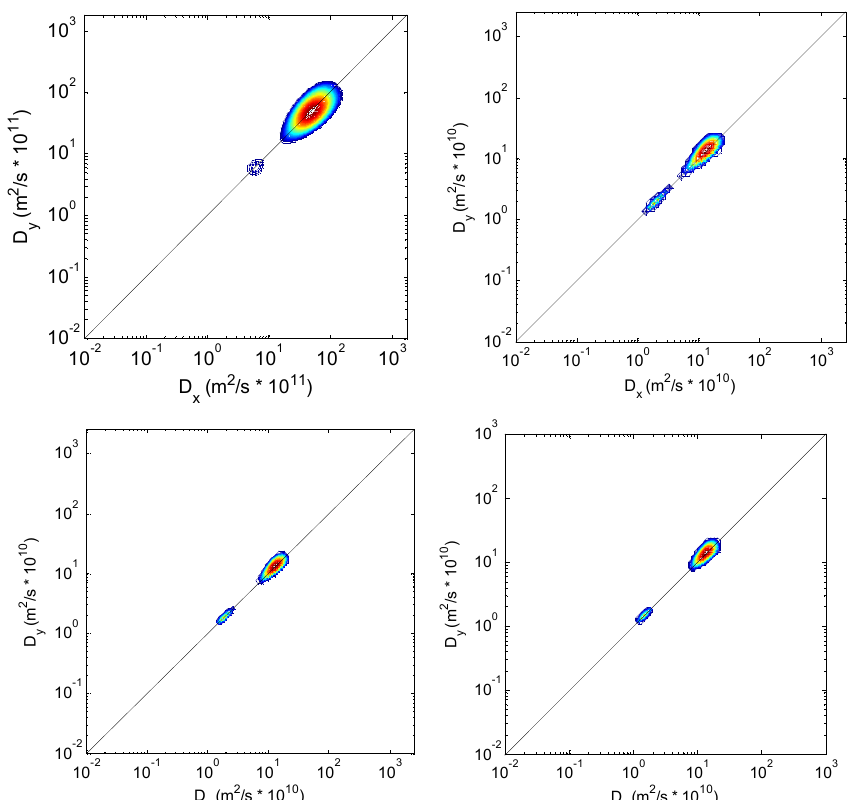
Figure 7. 2D di ff usion-di ff usion correlation maps obtained in simulated two-dimensional experiment (top, left) and 2D DDCOSY NMR experiments on three spruce samples (with variable moisture: 0.60 (top, right); 0.58 (bottom, left); 0.57 g H 2 O / g dry mass (bottom, right)) with the collinear pairs of the magnetic field gradient pulses. Simulation (top, left) has been done at D 1 = 2 × 10 − 10 m 2 / s, D 2 = 10 − 9 m 2 / s. Di ff usion anisotropy is characterized by two stretched spots on the diagonal whereas in the case of isotropic di ff usion one spot on the diagonal is observed.